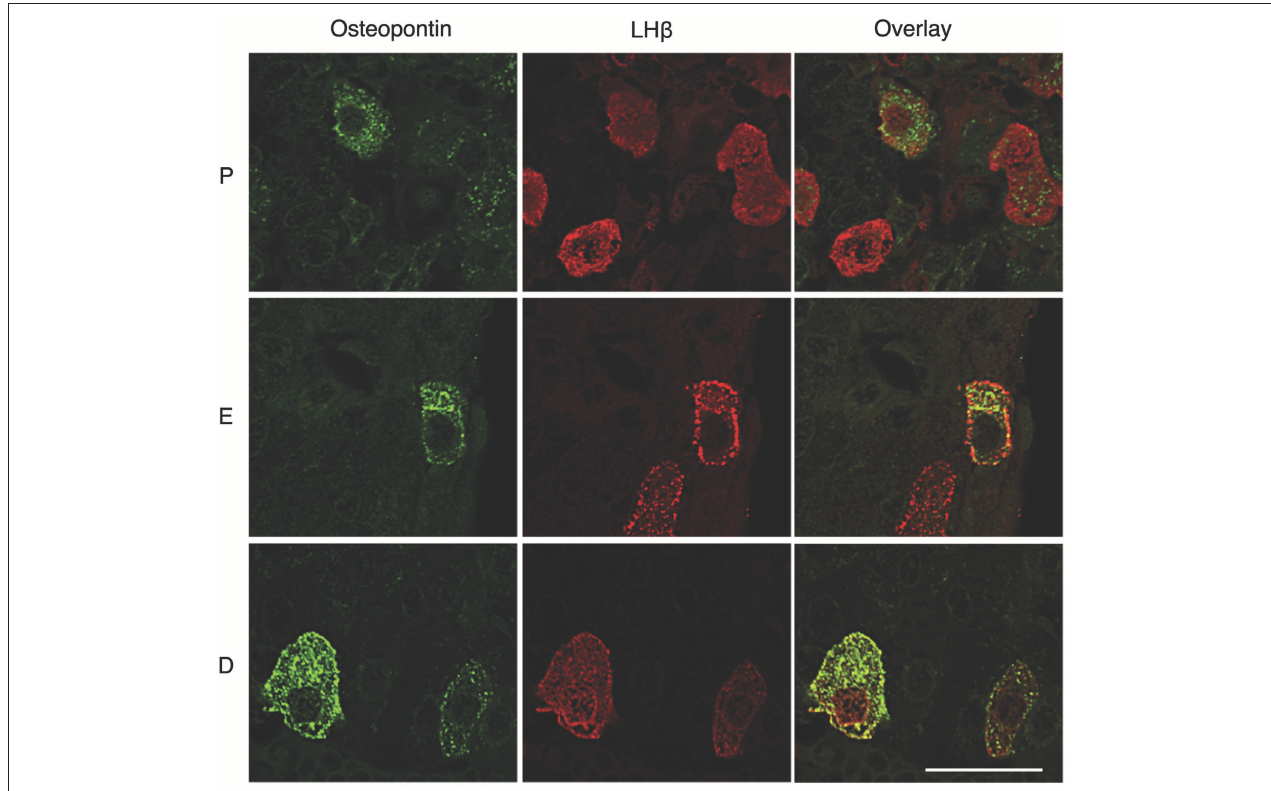
FIGURE 6 | Estrous cycle influences OPN expression in the pituitary tissue. Gonadotrophs were more intensively labeled in diestrus (D), when compared to proestrus (P) and estrus (E). Scale bar = 20 µ m applies to all